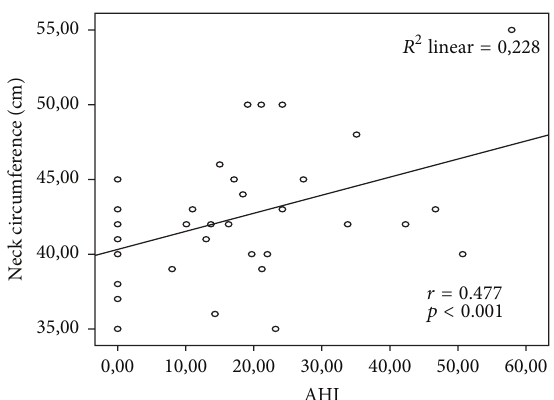
Figure 1: Pearson correlation analysis between AHI and neck cir- cumference.